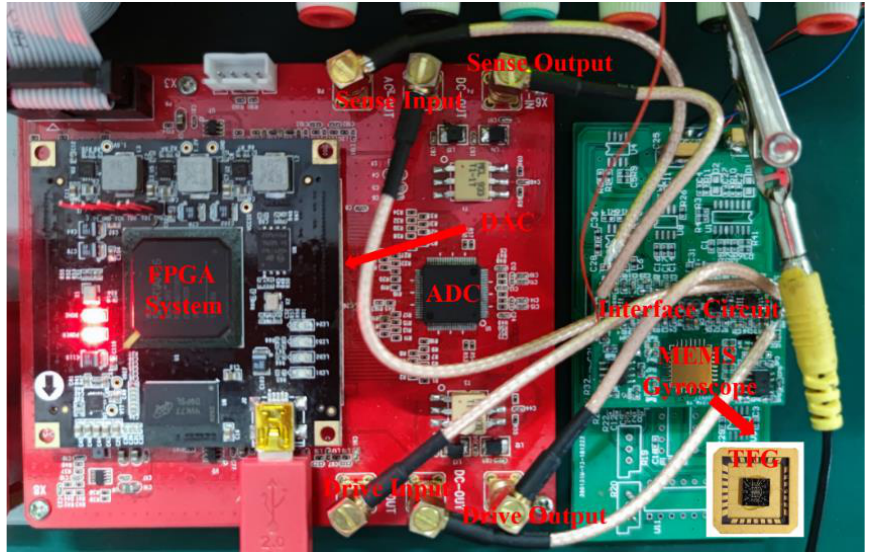
Figure 4. A photograph for the constructed testing system.